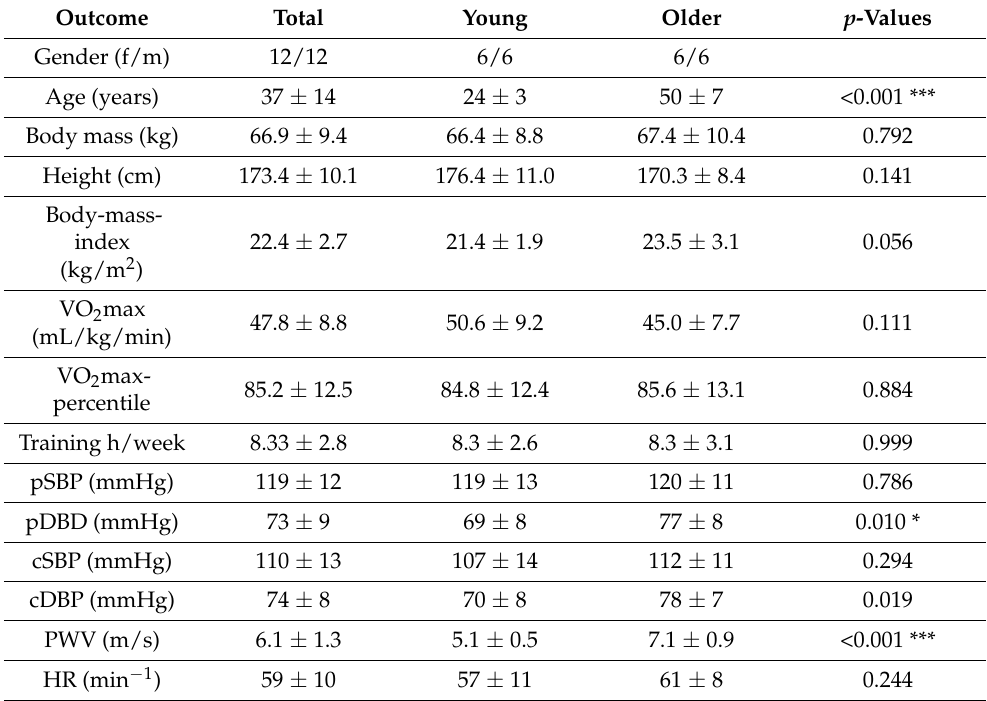
Table 1. Participant’s